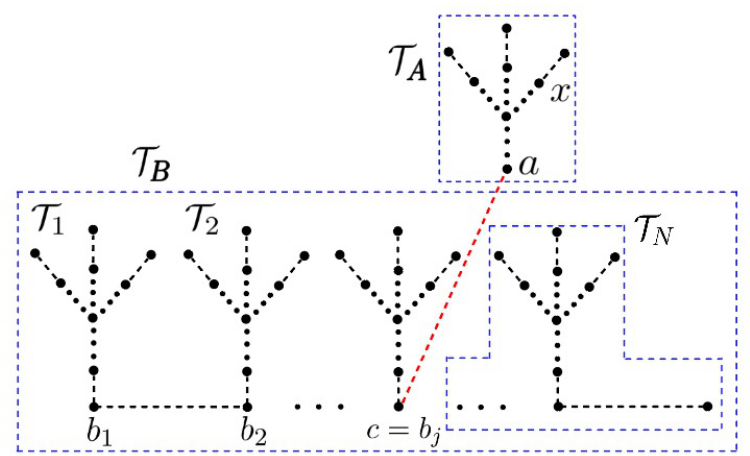
Figure 10 . This graph is constructed by connecting two arbitrary nodes a and c in graphs T AAA and T BBB together. The nodes x and b = b 1 are taken as the leftmost elements in T AAA and T BBB ,